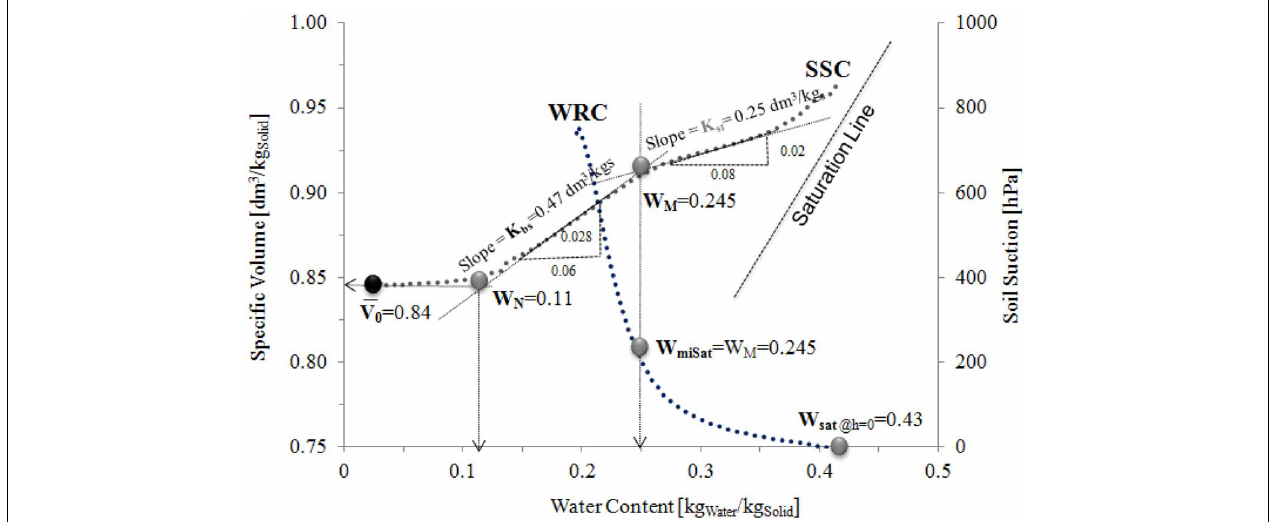
FIGURE 4 | Extracting the characteristic parameters of WRC and SSC in the case of sigmoidal shrinkage curve with no saturated interpedal water [Core#AM69]. The black dot and text indicate that